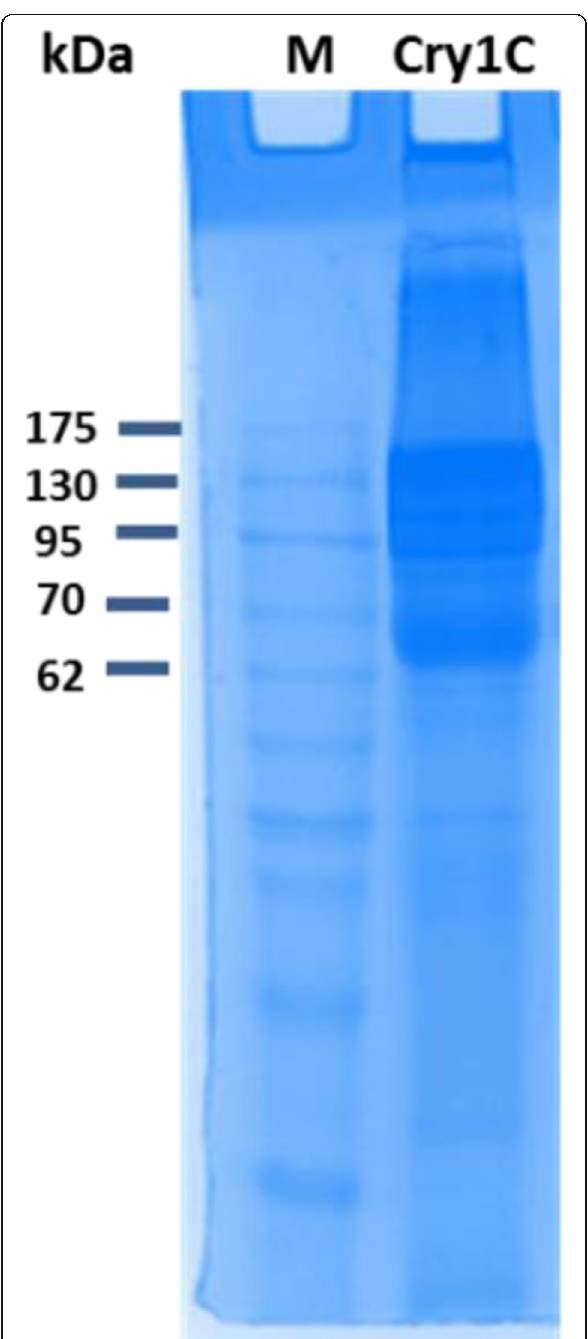
Fig. 1 SDS-PAGE of partially purified Cry1C toxin. M, Chromatin pre- stained marker; Cry1C, BtCry1C